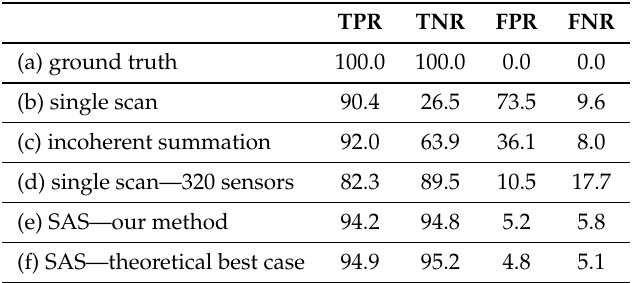
Table 2. Numeric True/False (T/F) Positive/Negative (P/N) rates (R) for the qualitative results shown in Figure 11. Please see the text for a discussion.